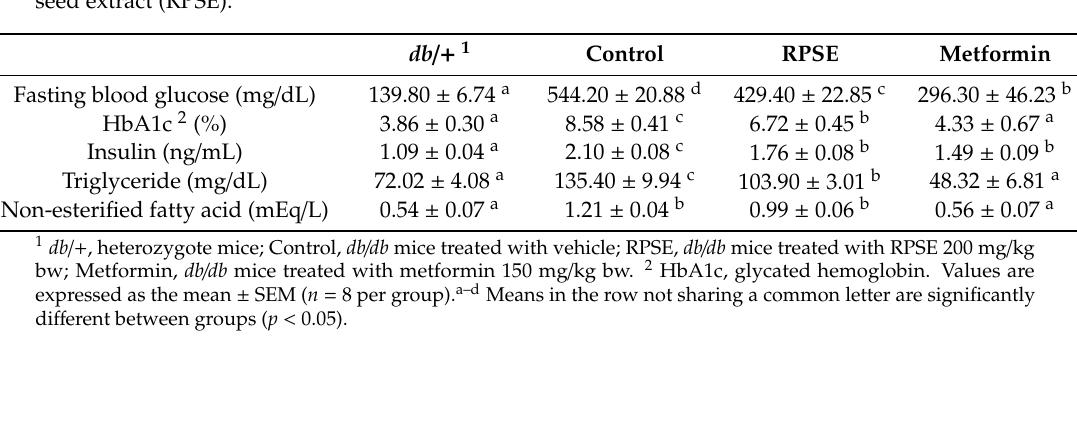
Table 2. Type 2 diabetes mellitus biomarkers in the plasma of db / db mice supplemented with red pepper seed extract